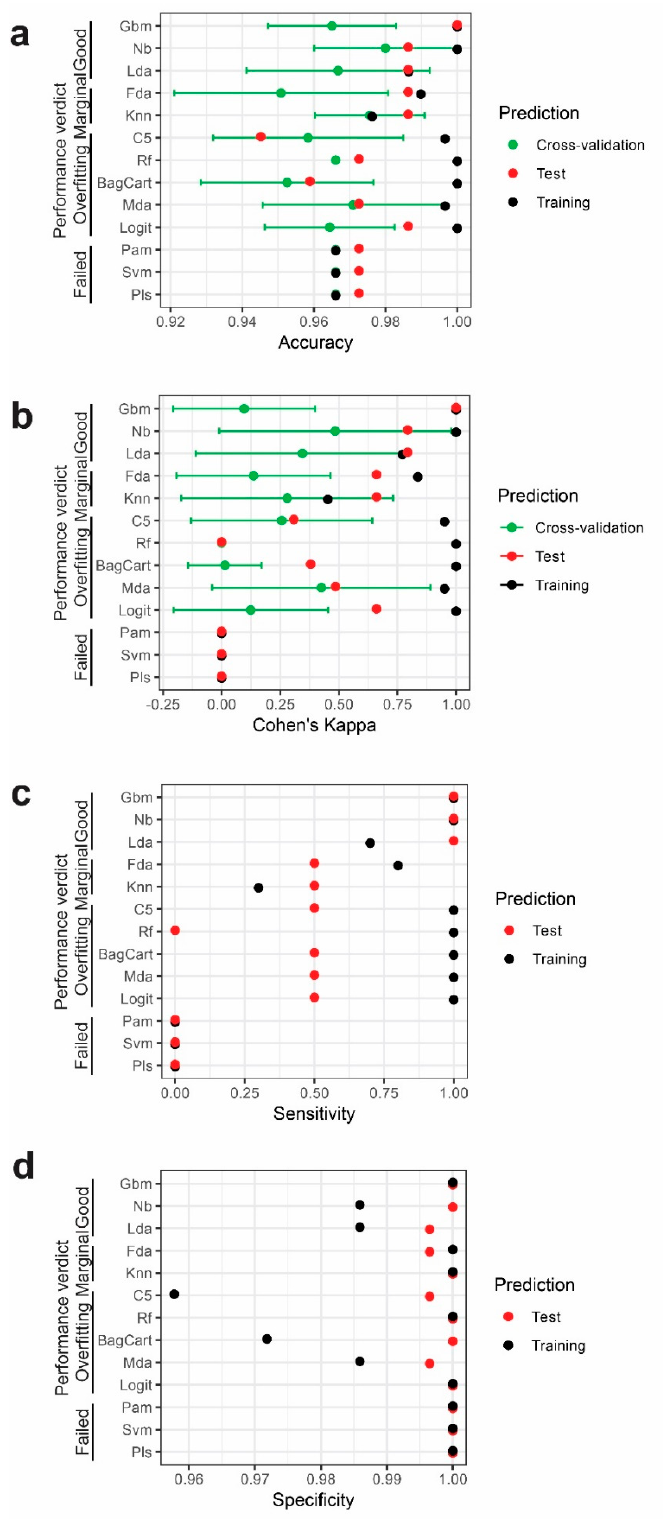
Figure 6. Model performance. ( a – d ) Model performance metrics—namely, accuracy ( a ), Cohen’s Kappa ( b ), sensitivity ( c ) and specificity ( d )—were illustrated in cross-validations (green dots and error bars), Training Set (black dots) and Test Set (red dots) for all models. Models are categorized into 4 groups based on their performances.